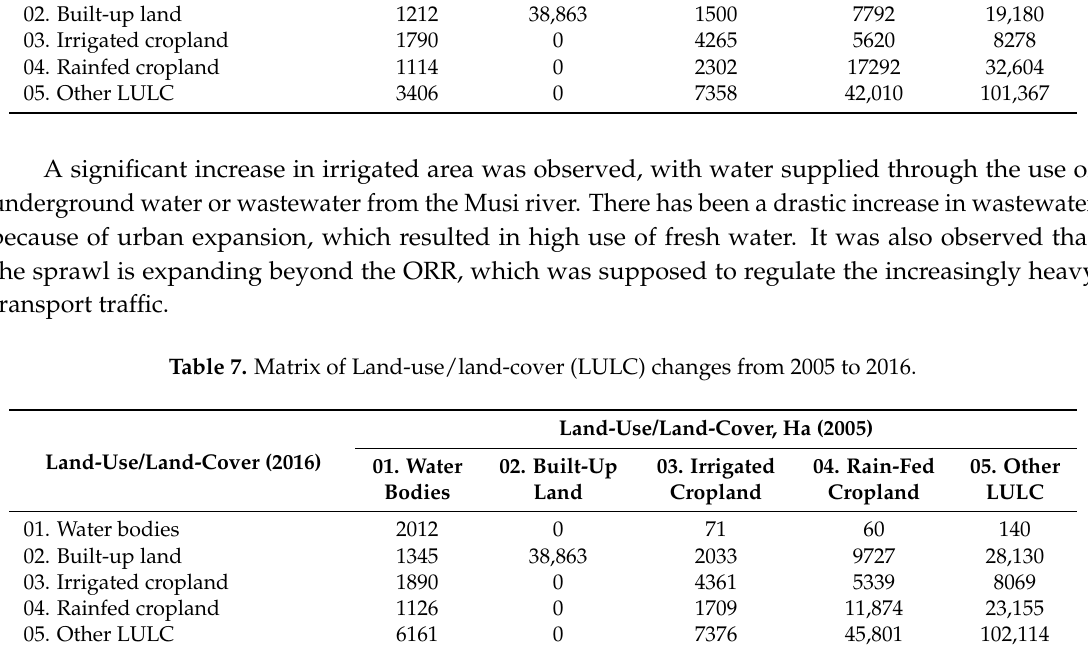
Land-Use/Land-Cover (2011)